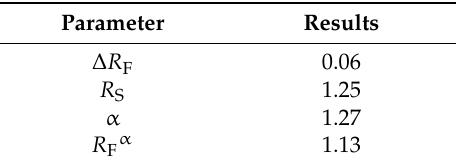
Table 1. Parameters of chromatographic separation of clobetasol propionate and clobetasol using proposed TLC-densitometric method.